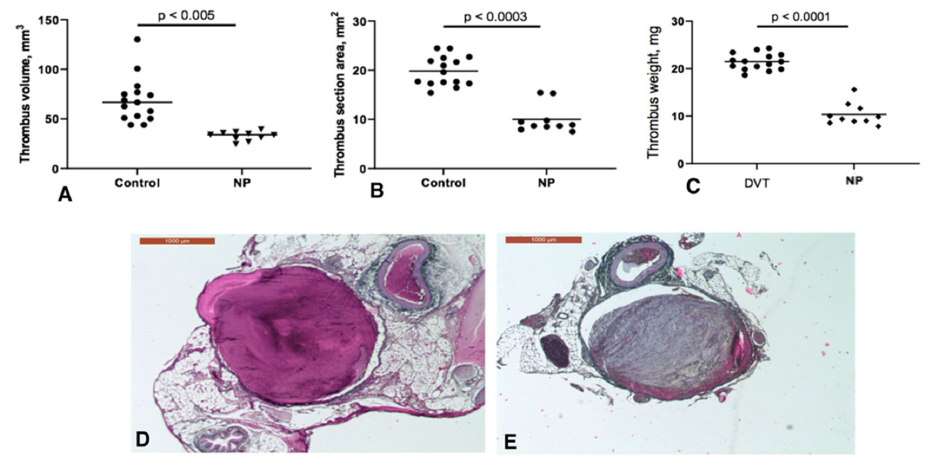
Figure 1. Thrombosis in the IVC: Volume ( A ), area ( B ) and weight ( C ) of thrombi in normal (Control) and neutropenic (NP) conditions. Horizontal line represents median. ( D , E ), sections of thrombi in the IVC of non-neutropenic and neutropenic rats, respectively, stained by the Martius Scarlet Blue (MSB) method. Red, fresh fibrin; blue, organized fibrin/connective tissue. Scale bar 1 mm. Representative images out of 10–15 experiments.